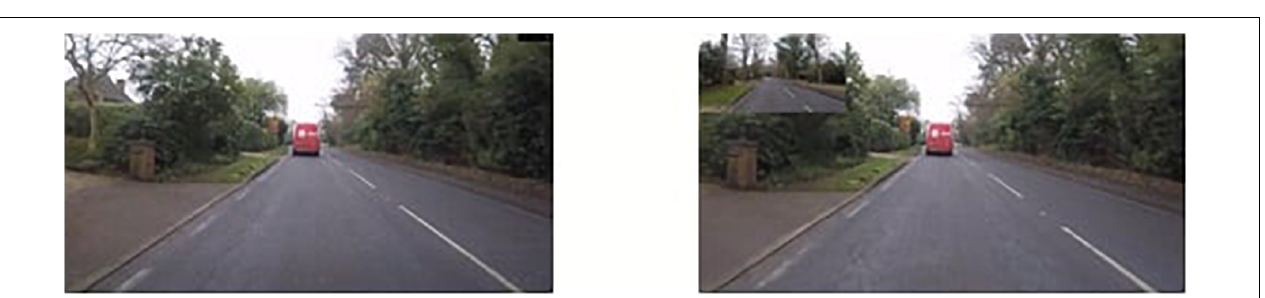
FIGURE 2 | Images showing the two versions of the video, without ( left image) and with a rear-view insert ( right hand